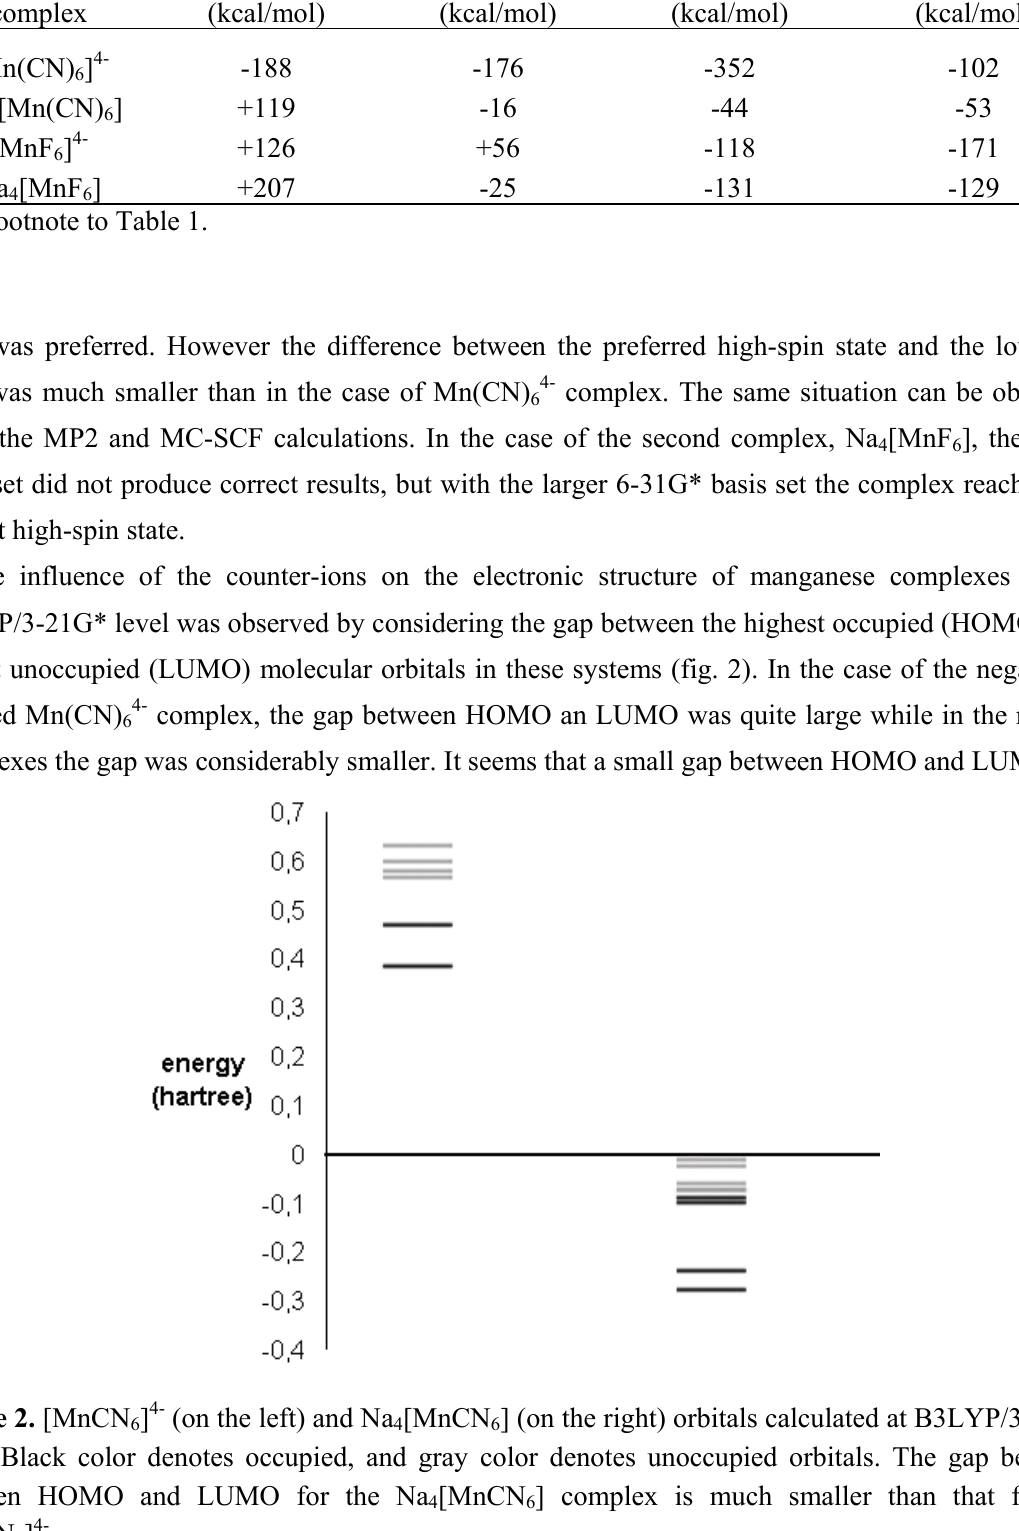
] 4- and Na [MnX ] 6 4 6